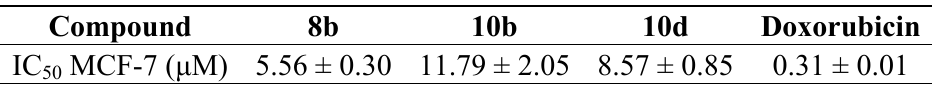
Table 5. Effect of compounds 8b , 10b , and 10d on